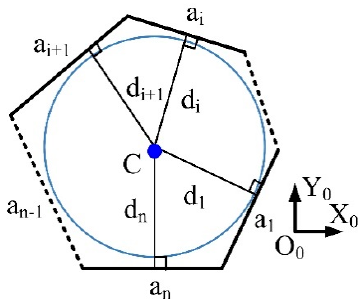
Figure 8. Diagram of the stability margin.